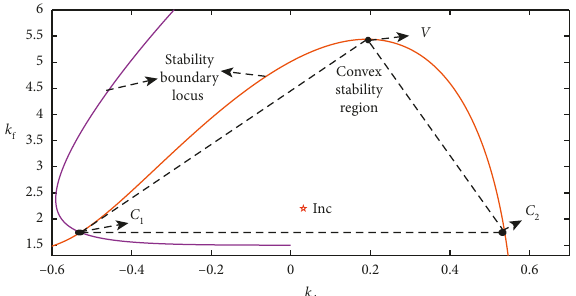
Figure 9: Common convex stable region and incenter of PD controller in example